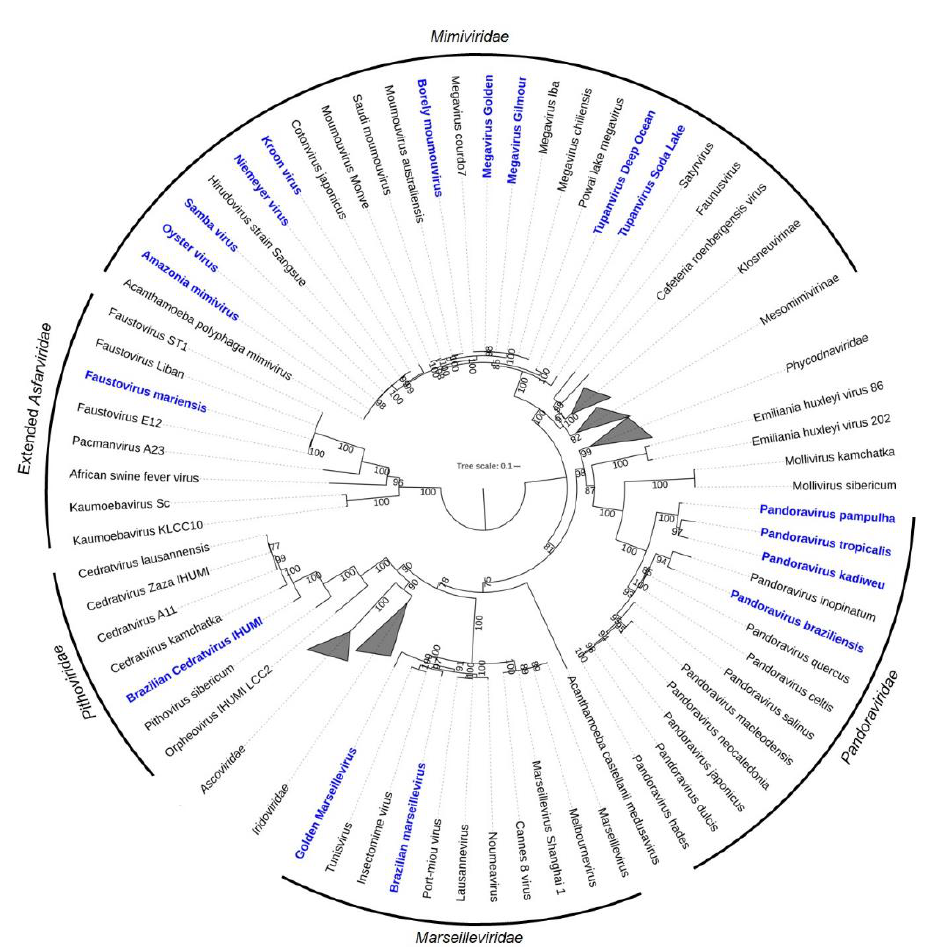
Figure 3. Maximum likelihood phylogenetic tree based on amino acid sequences of DNA polymerase B family of Nucleocytoviricota . Brazilian isolates are bold and highlighted in blue. Sequences were aligned using Muscle [48] and low conserved regions were removed using trimAl [49]. The tree was built using IQ-TREE [50] with 1000 ultrafast bootstrap replicates and the VT+F+R7 model chosen by ModelTest according to Bayesian Information Criterion. The tree was visualized in iToL [51]. The tree scale indicates the substitution rate.